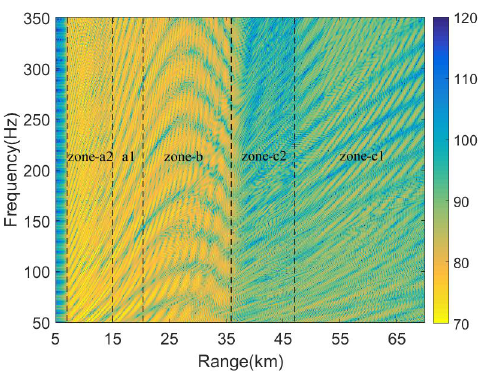
Figure 7. Intensity versus range and frequency. According to Figure 6, it is divided into five sections: zone-a2, zone-a1, zone-b, zone-c2 and zone-c1.